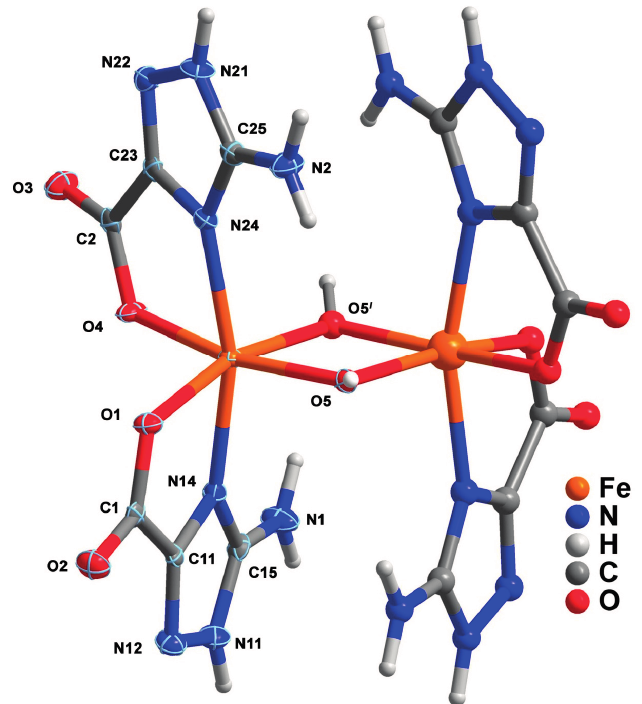
Figure 5. Representation of the binuclear complex [Fe 2 (Hatrc) 4 (OH) 2 ] present in compound 3 , showing the labelling scheme for all non-H atoms composing the asu and the Fe1 coordination environment. Non-H atoms of the asu are represented as thermal ellipsoids (70% probability level) and the remaining atoms as spheres with arbitrary radii. For selected bond lengths and angles see Table 3. Symmetry operation: l = x , 0.5 − y , 0.5 −